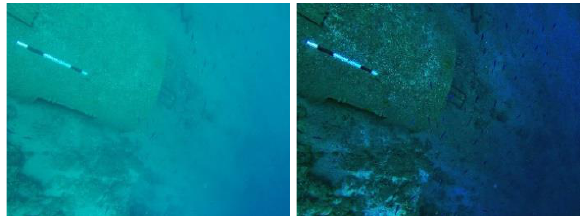
Figure 5. Left : initial image; right : enhanced image.